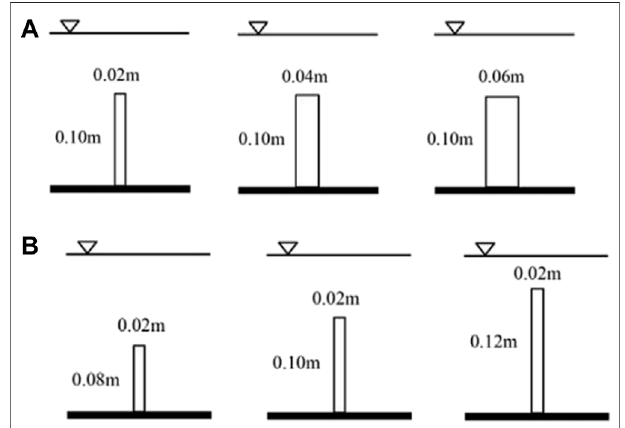
FIGURE 8 | Schematic view of the submerged barrier of different geometrical sizes: (A) setup for different widths ( W (cid:2) 0.02 m, 0.04 m, 0.06 m) with a fi xed height ( L (cid:2) 0.1 m); and (B) setup for different heights ( L (cid:2) 0.08 m, 0.10 m, 0.12 m) with a fi xed width ( W (cid:2) 0.02 m).